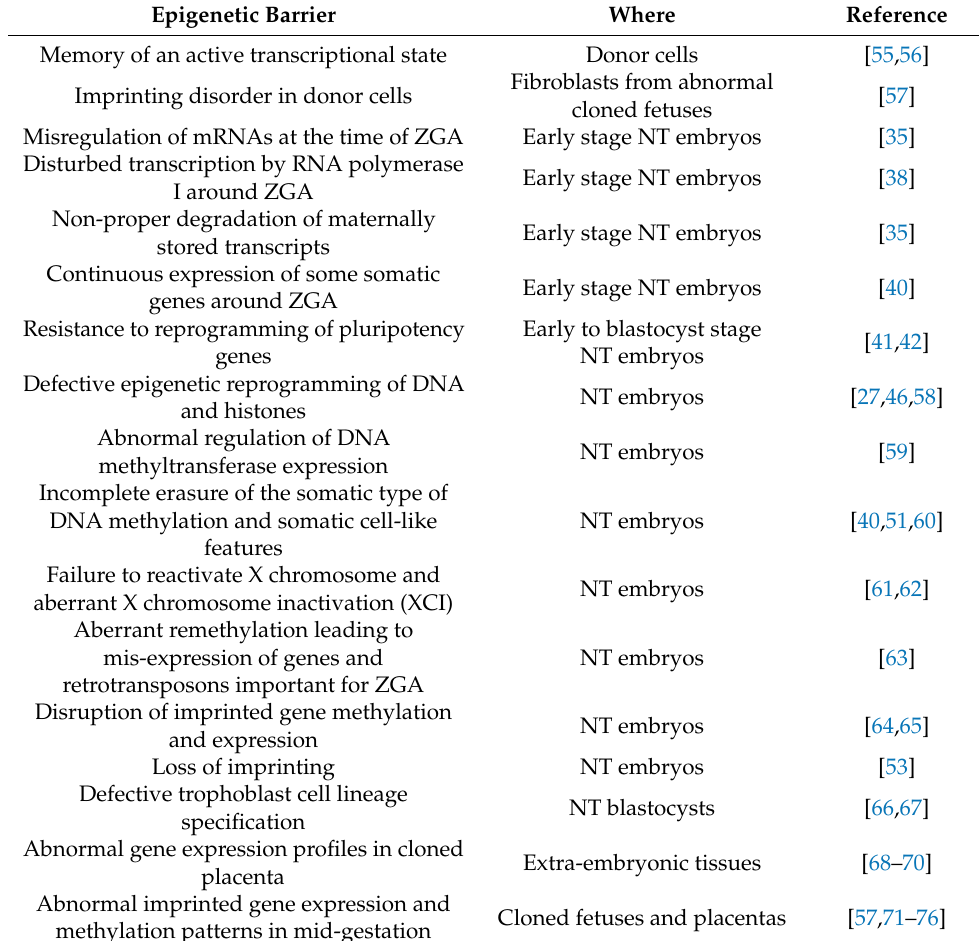
Table 1. Epigenetic barriers to somatic cell nuclear transfer